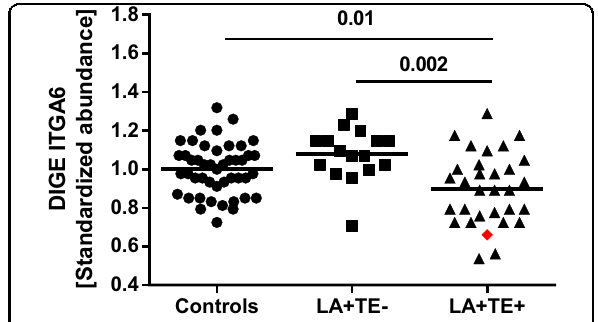
Fig. 4 Standardized abundance of integrin α 6 (ITGA6) in the human platelet proteome. Protein abundance of ITGA6 was signi fi cantly reduced in LA + TE + patients compared to healthy controls ( p = 0.01) and patients without thrombosis ( p = 0.002). Each dot represents a measurement of a single patient. The patient with CAPS is visualized as a red rhombus. The line between the dots represents the mean. FDR-corrected t -test was used to compare differences between groups. LA lupus anticoagulant, TE thromboembolism, 2D-DIGE two-dimensional differential in-gel electrophoresis, CAPS catastrophic antiphospholipid antibody